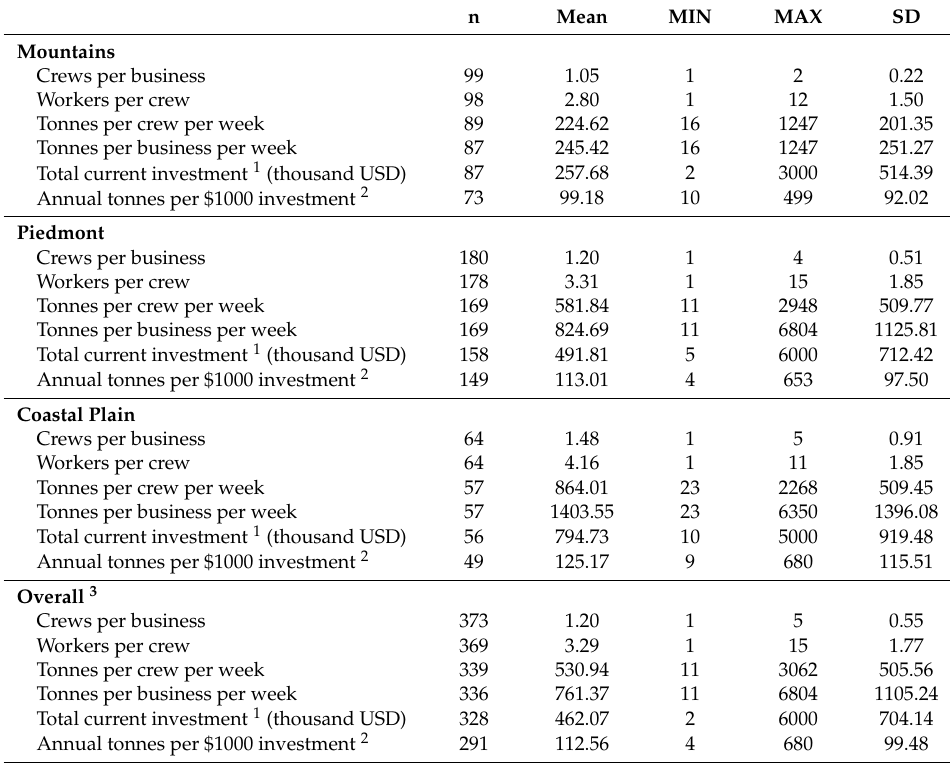
1 Indicates current value of harvesting equipment excluding trucking. 2 Annual production (tonnes) calculated using reported weekly production × 50 weeks/year. 3 Includes responses from all Virginia regions and adjoining states or regions not specifically